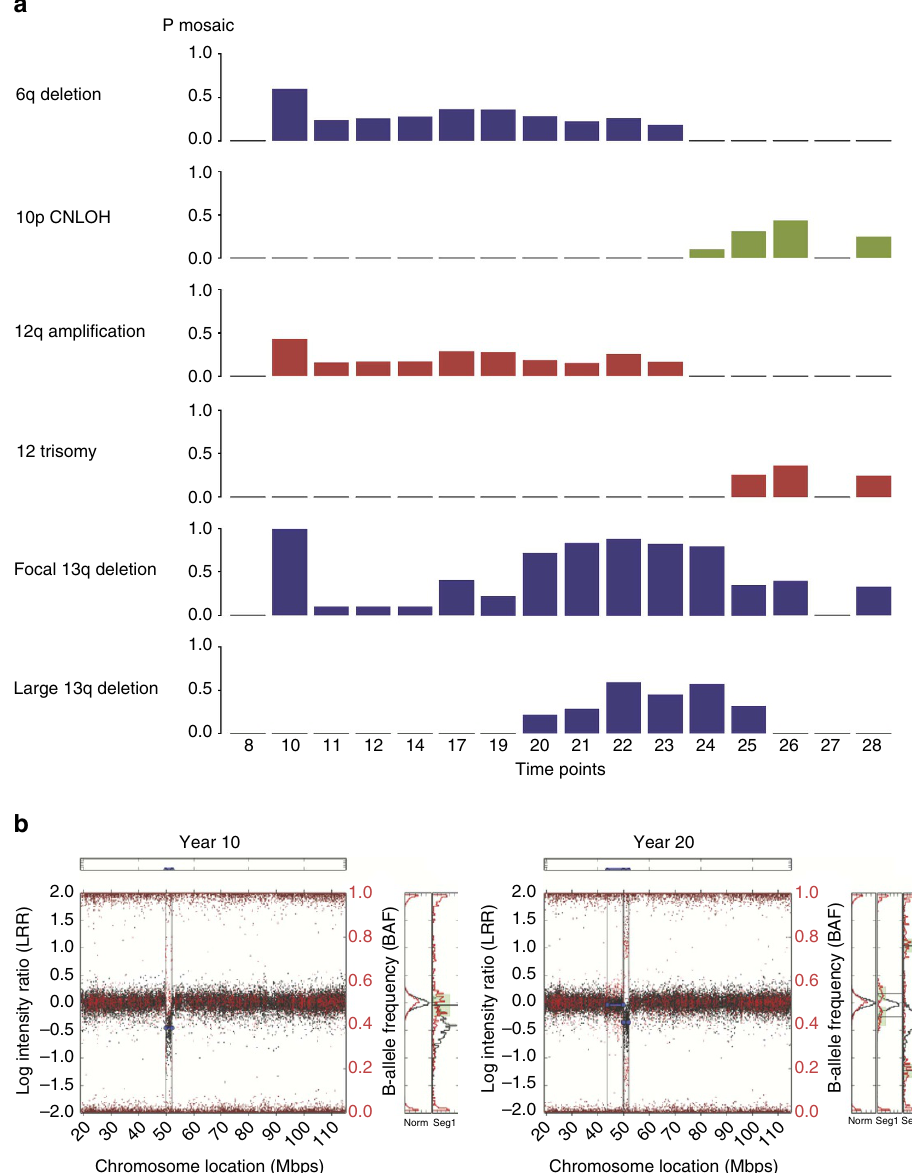
Figure 2 | Representative CNV profiles detected by SNP microarray. ( a ) The CNV profiles of 16 time points during the years 8–28 from diagnosis are shown. ( b ) The SNP array plots of 13q (cid:2) in years 10 and 20 are